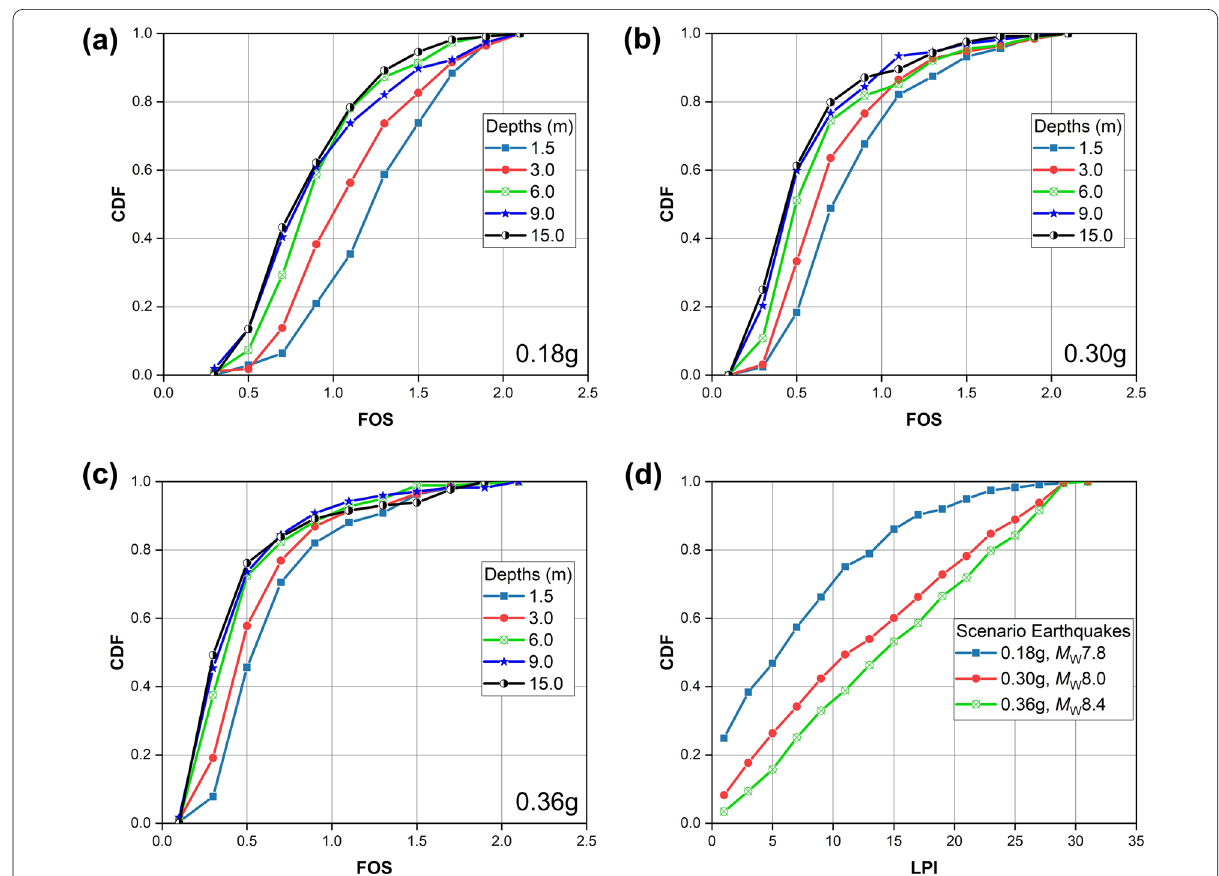
Fig. 8 Cumulative distribution function (CDF) for FOS against liquefaction at PGA of a 0.18 g b 0.30 g, c 0.36 g against liquefaction, and d liquefaction potential index (LPI) for three seismic